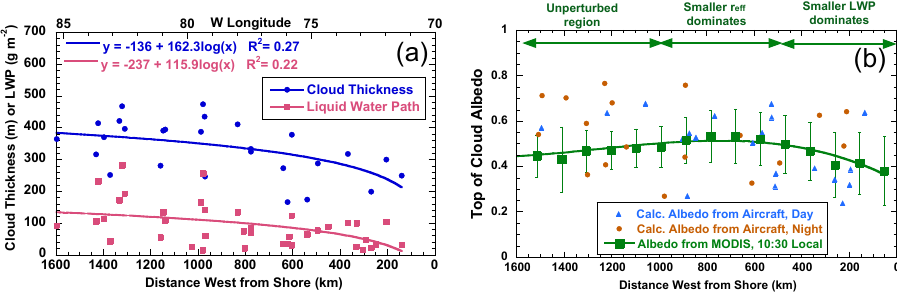
Fig. 14. (a) Cloud geometric thickness and liquid water path (LWP) as a function of distance west from shore along 20 ◦ S. Thickness is from the in-situ radar and lidar, while LWP uses both GVR and radar data. Uncertainty is estimated to be 30 m for geometric thickness (D. Leon, personal communication, 2012) and 20gm − 2 for LWP (Zuidema et al., 2012). (b) Top of cloud albedo vs. distance from shore calculated as described in the text (using 10:30 local values for solar zenith angle). Circles are values derived from onboard remote sensors during daytime (purple) and night-time (blue) C-130 flight segments, while green squares are derived from the MODIS 10:30 local overpass averaged over the entire VOCALS 31-day time period. Vertical bars represent one sigma variability in the MODIS data. Since in-cloud data only was used, cloud albedos here are higher than net albedos in partly cloudy